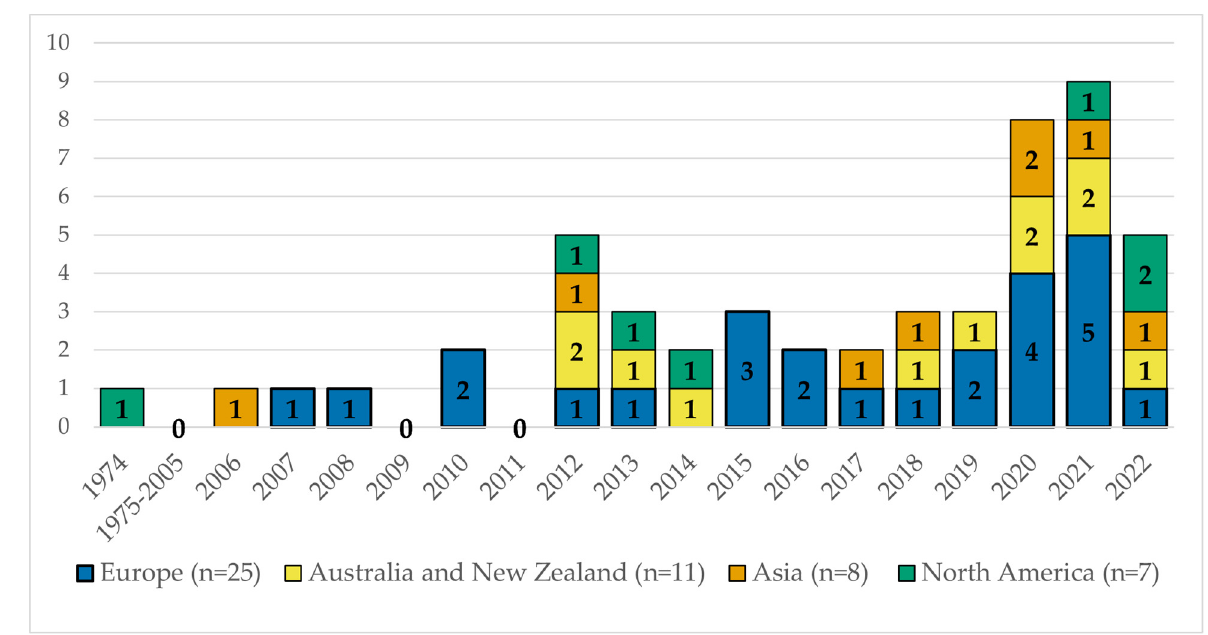
Figure 2. Number of included publications in the review period 1974–2022 ( n = 51) by continent. Table 3. Data collection methods of the included publications.